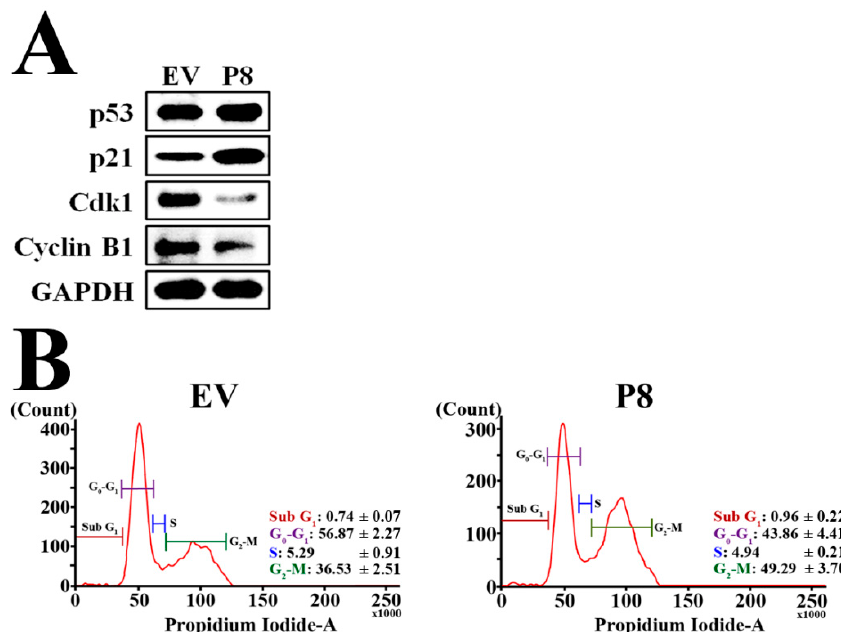
Figure 4. P8 targets anti-cancer signaling pathways in DLD-1 cells. ( A ) Western blot showing the effect of endogenous p8 expression on molecules associated with G 2 arrest in DLD-1 cells (EV, empty vector). ( B ) To determine the effects of endogenous p8 expression on the cell cycle, cells were harvested and subjected to flow cytometry analysis. Endogenous r-p8 induced arrest of DLD-1 cells at G 2 phase.